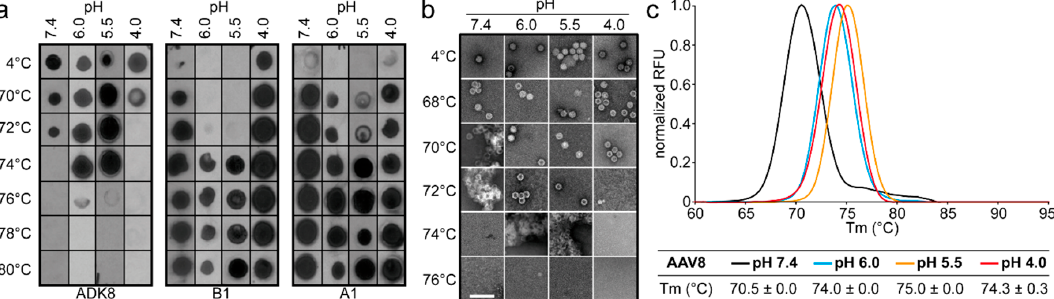
Figure 4. AAV8 stability analysis. ( a ) Dot immunoblots of AAV8-GFP vectors at different pHs representative of physiological (7.4), early endosomal (6.0), late endosomal (5.5), and lysosomal (4.0) conditions. The virus was heat-shocked at the temperature indicated and blotted for intact capsids (ADK8), denatured capsids (B1), and the accessibility of VP1u (A1). ( b ) Negative-stain EM of AAV8-GFP vectors treated as in ( a ). Scale bar: 100 nm. ( c ) T m of AAV8 VLPs determined by DSF at the pH conditions used in ( a ) and ( b ). A thermal profile for each pH condition is shown as normalized relative fluorescence units (RFUs) versus temperature (in °C). All experiments were performed in triplicate. At pH 7.4, the observed thermostability for AAV8 using dot immunoblots, EMs, and DSF indicated that the AAV8 capsids were intact to 70.5–72 °C (Figure 4). The capsids were stable to 74– 75 °C at pH 6.0 and 5.5 (Figure 4). Dot immunoblot and EM studies at pH 4.0 showed that the capsids were intact to ~70 °C (Figure 4a and b); however, DSF indicated stability to 74.3 °C (Figure 4c). This discrepancy of a higher T m at pH4.0, determined by DSF, is also seen for AAV1 and AAV2 (Figure 1 and 2). Unlike AAV1, AAV2, and AAV5, the B1 signal was detected at 4 °C at pH 4.0, suggesting that there are either partially broken capsids in the sample or that rearrangements occurring at a low pH [6] expose this epitope (Figure 4a). However, the A1 epitope was detected at lower temperatures at pH 6.0 and 5.5, suggesting that the VP1u was surface-exposed before the capsids denatured, unlike the observation for the other serotypes. 3.2. AAVs Modify Liposomes When Heated to Externalize VP1u and at pH 5.5 The effect of the AAV viral PLA 2 enzymatic activity on POPC liposomes was visualized by negative-stain EM. This phospholipid was selected for this study because it accounts for >50% of all the lipids found in eukaryotic membranes: ~40% in plasma membranes, and ~50% in the late